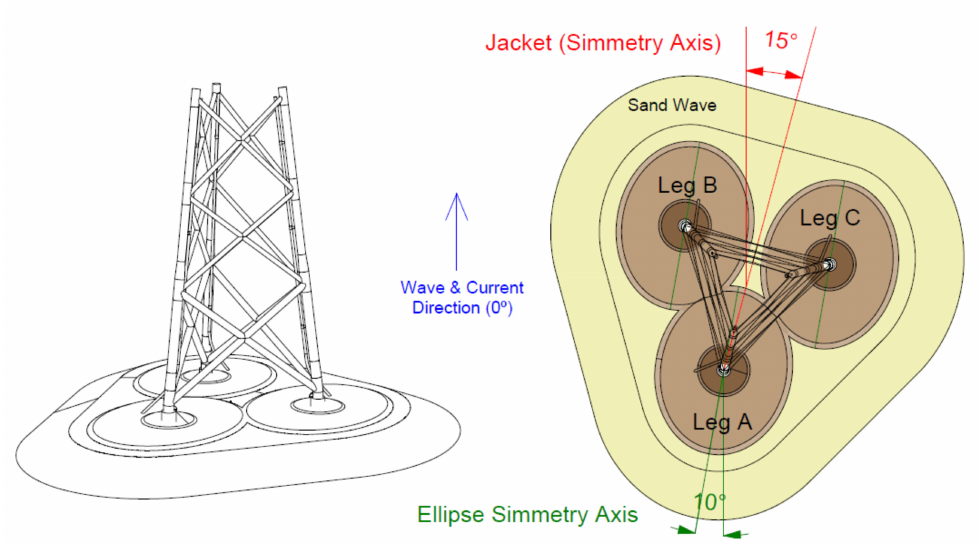
Figure 6. Sketch of Platform orientation, Rock scour protection orientation, and Sand wave orientation.